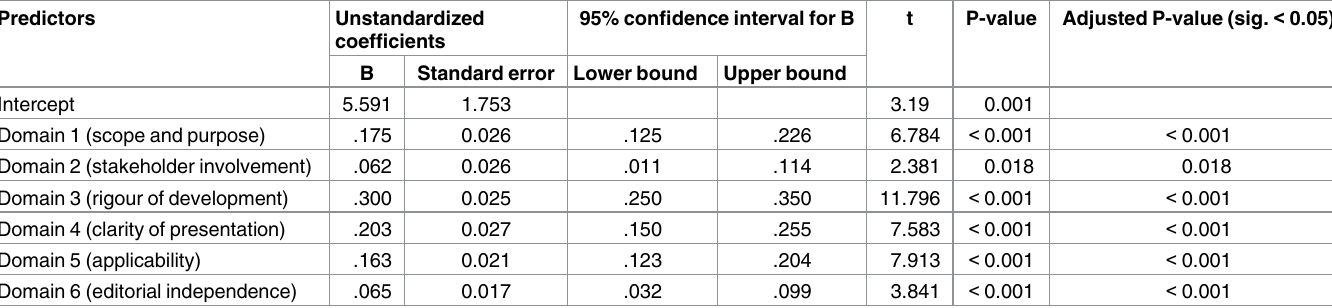
Table 2. Results of the multiple regression analysis (independent variable: Overall guideline